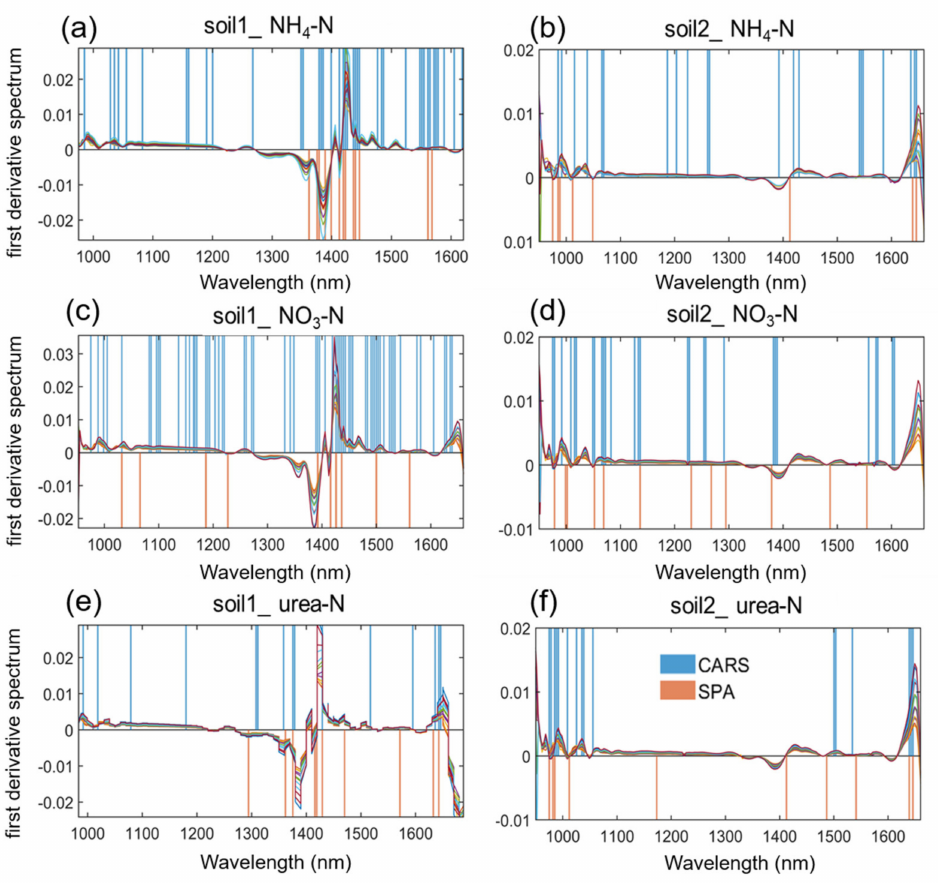
Figure 3. The positions of the characteristic wavelengths on the first derivative spectra: ( a ) Soil1_NH 4 -